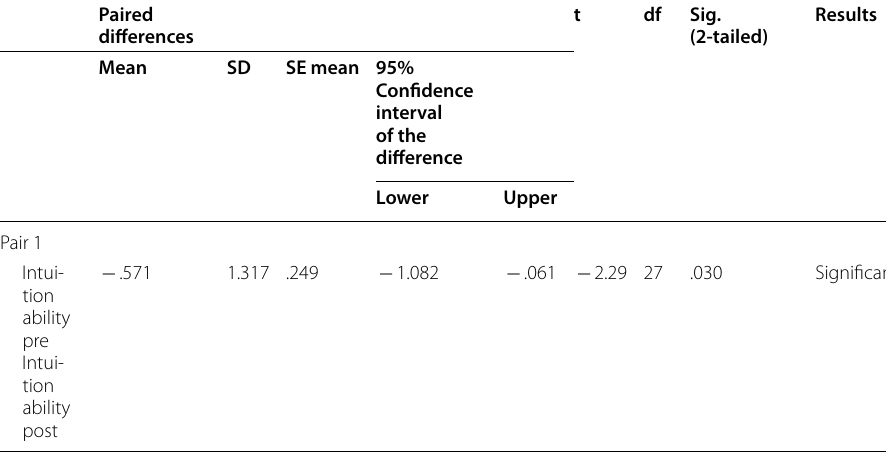
Table 8 Paired samples test: intuition ability. Source: SPSS 23.0 output Paired differences